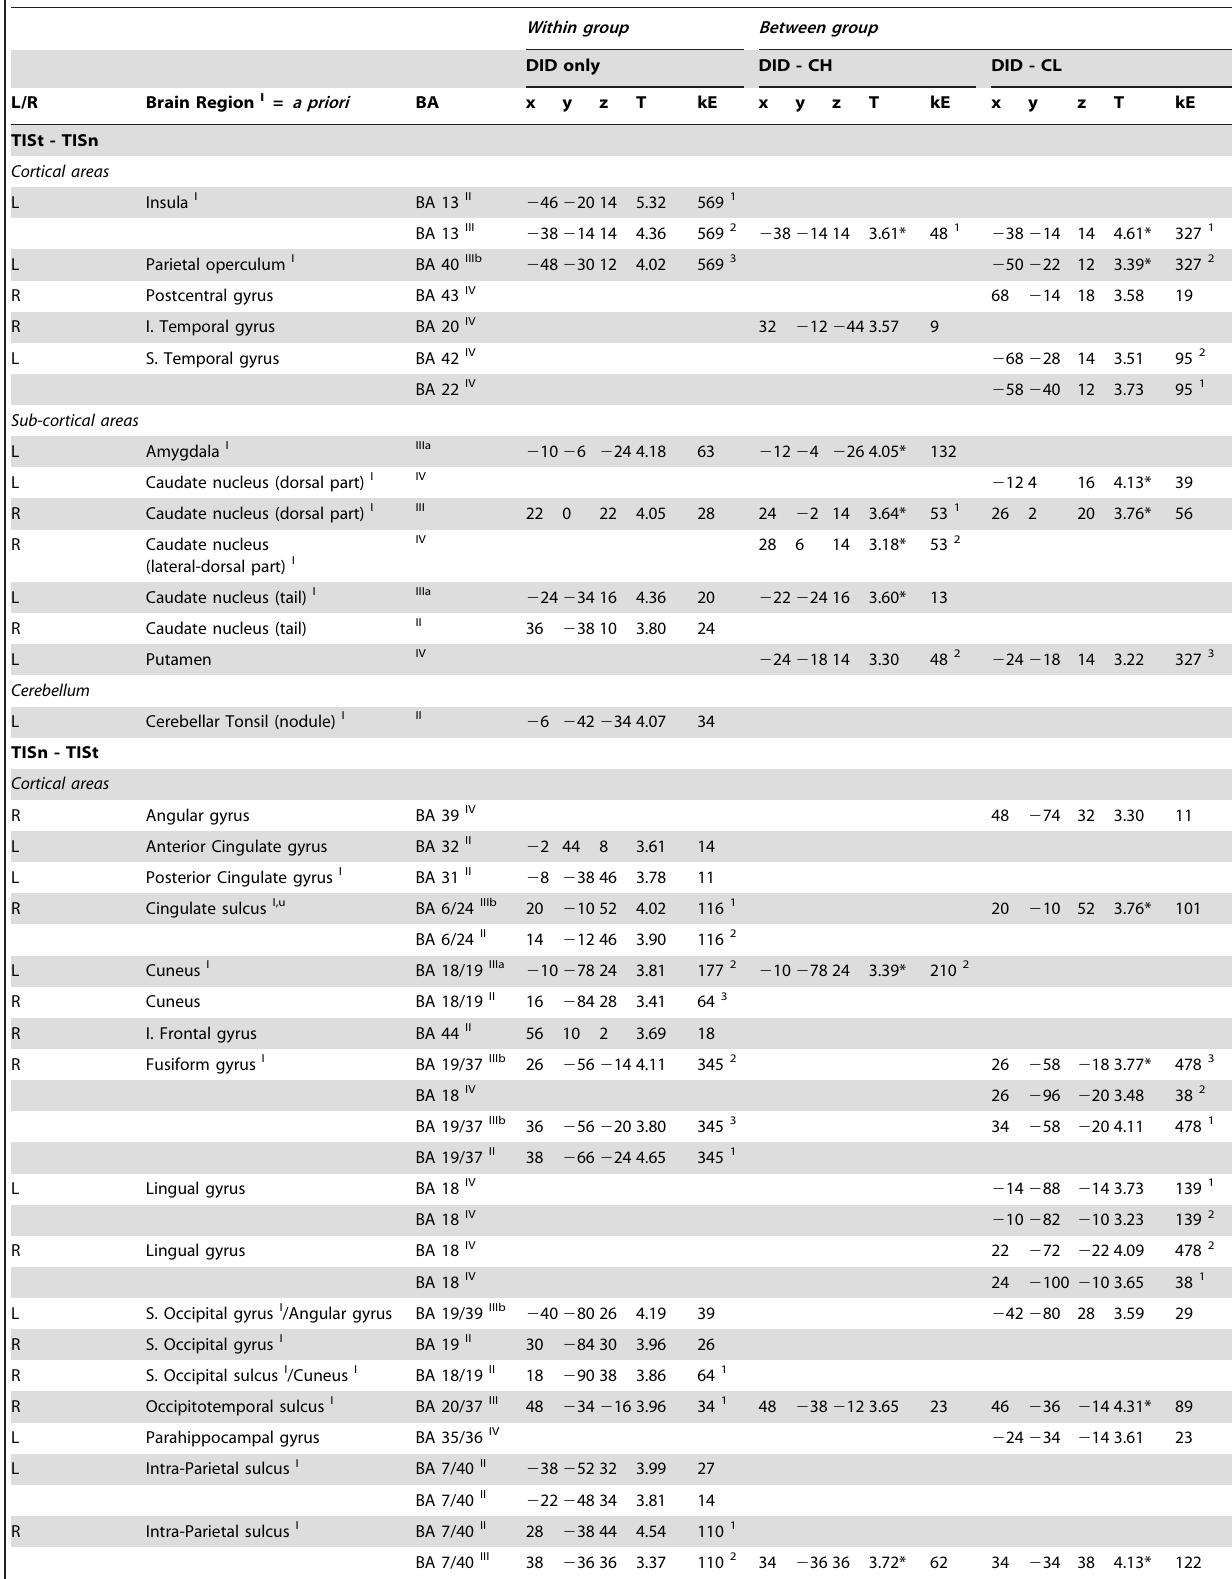
Table 3. Memory script effects within dissociative identity state.